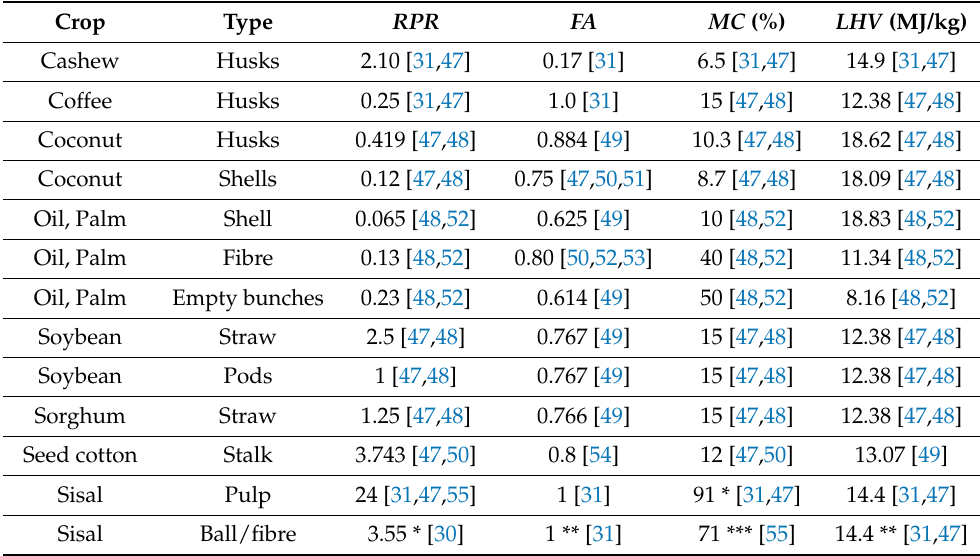
Table 2. Perennial plantation crop residue data.